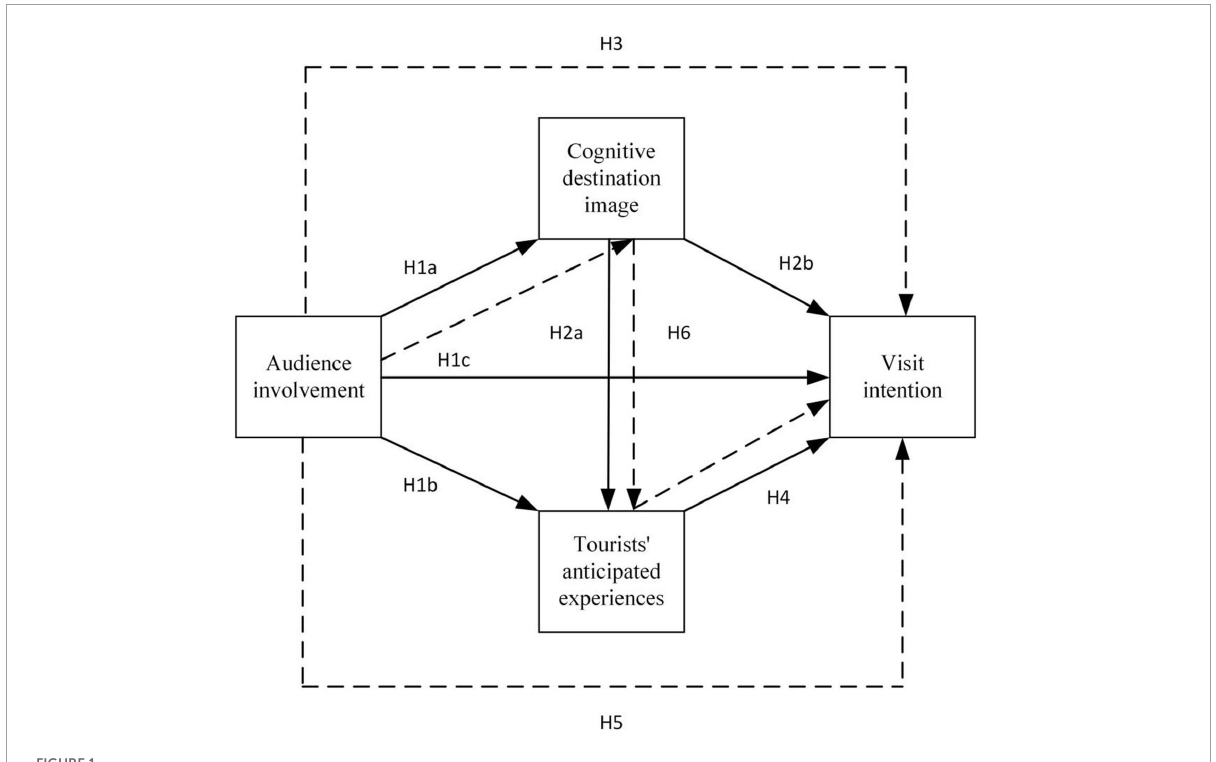
FIGURE1 Conceptual